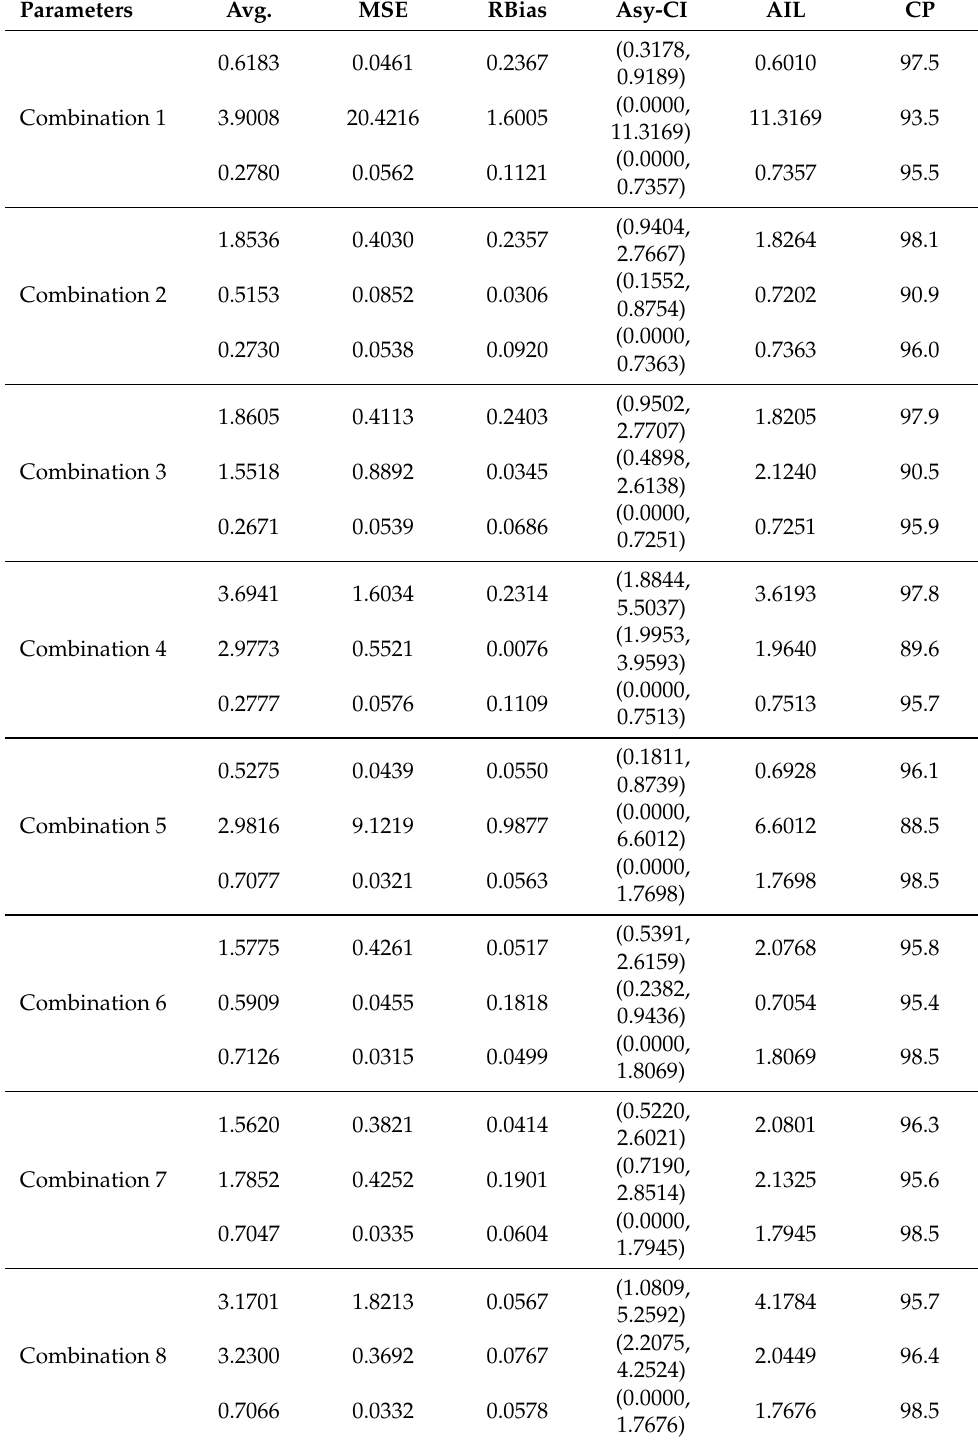
Table 10. Average estimated values, MSEs, CIs, AILs and CPs (in %) of the MLE for the FB distribution at N = 50 and n =